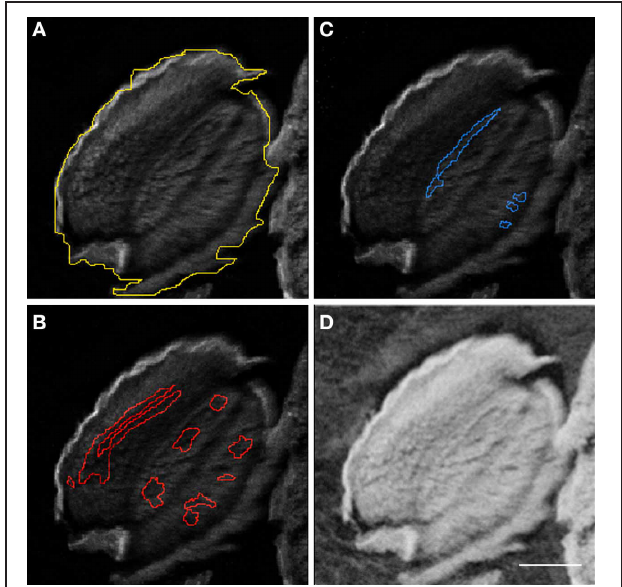
Element distribution maps allowed selection of regions of interest (ROI). Arabidopsis thaliana whole seed (A) , Fe- (B) , and Mn- (C) ROIs are shown using the Ca distribution map as background. The associated STIM image (D) shows the local mass of the sample which is necessary for quantification. Scale bar: 100 µ